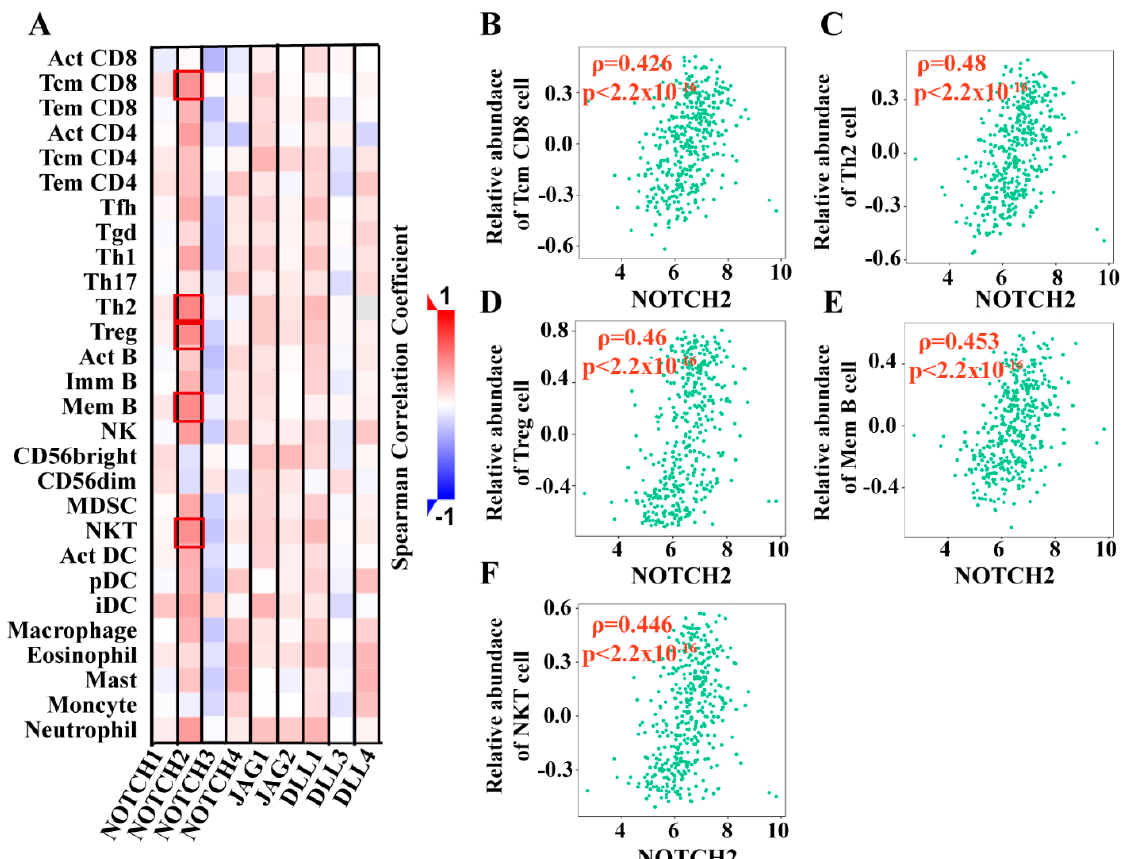
Figure 4. Correlation between Notch factors and lymphocytes. ( A ) The heatmap of correlation between the target genes and lymphocytes in BCa ( n = 408). (i) the value of Spearman correlation coefficient is color-coded; high value is marked in red; low value was marked in blue. (ii) The most significant results are marked with a red frame. ( B – F ) Representative moderate positive correlation of NOTCH2 with Tcm CD8 cells ( B ), Th2 cells ( C ), Treg cells ( D ), Mem B cells ( E ), and NKT cells ( F ) in BCa; p -value. x -axis = expression level of target gene, y -axis = relative abundance of lymphocytes, scatter plots show curved patterns of the samples. TISIDB (http://cis.hku.hk/TISIDB/browse, accessed on 18 March 2021)